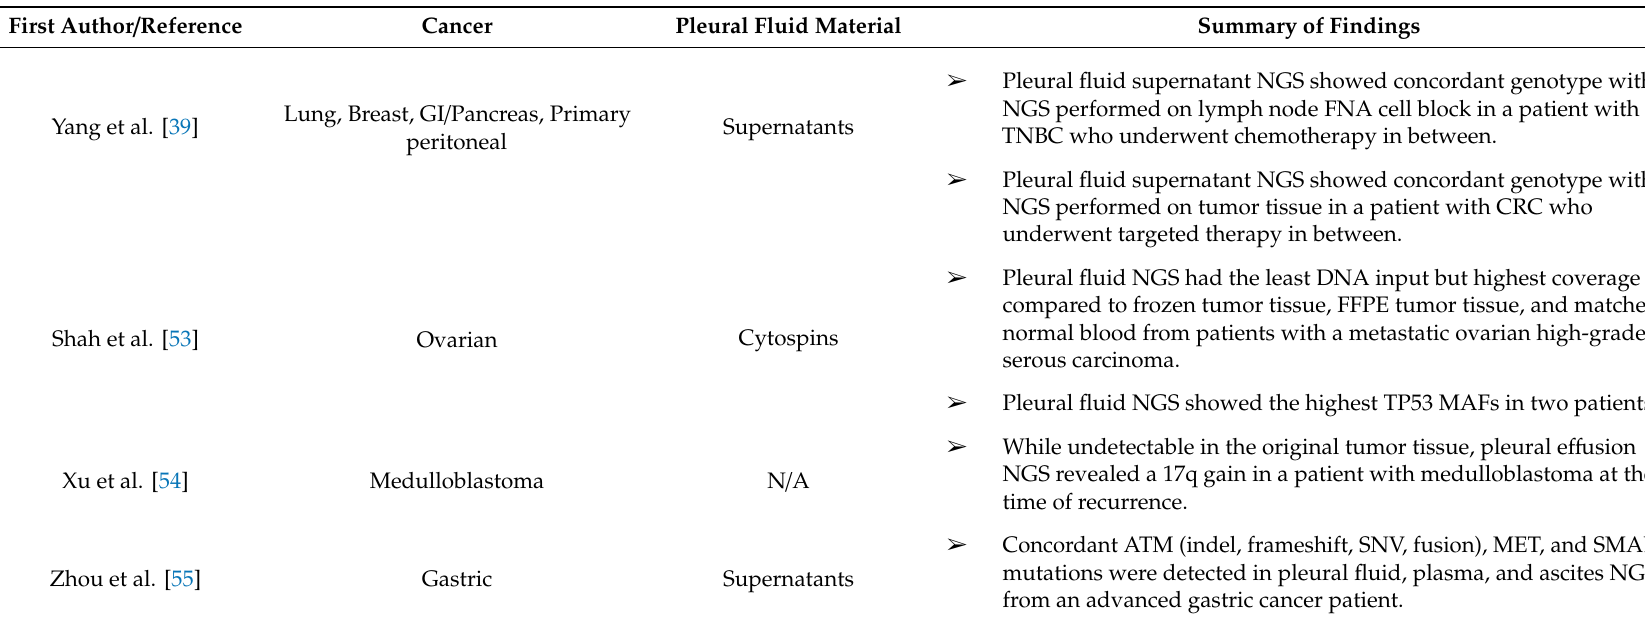
Table 5. The role of NGS in malignant pleural e ff usions from di ff erent types of cancers (other than